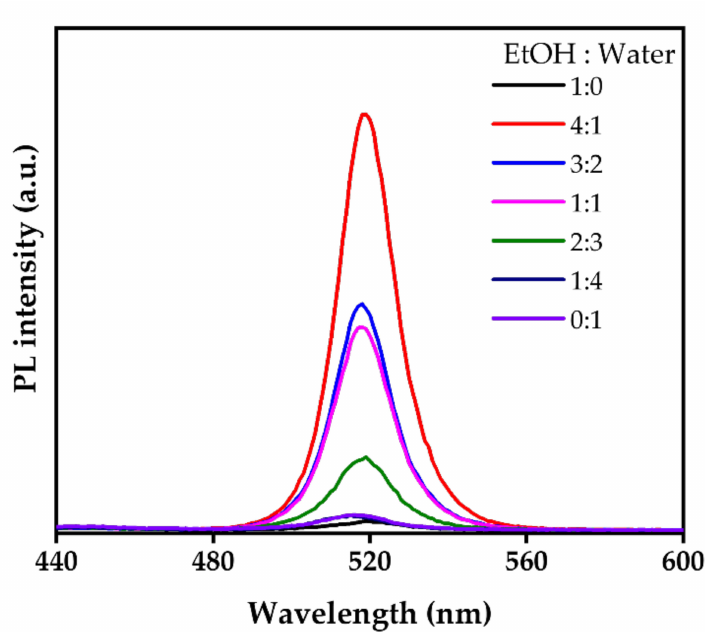
Figure 3. Comparison of the PL intensity of the CsPbBr 3 MC solutions obtained via the phase transition process with different ratios of